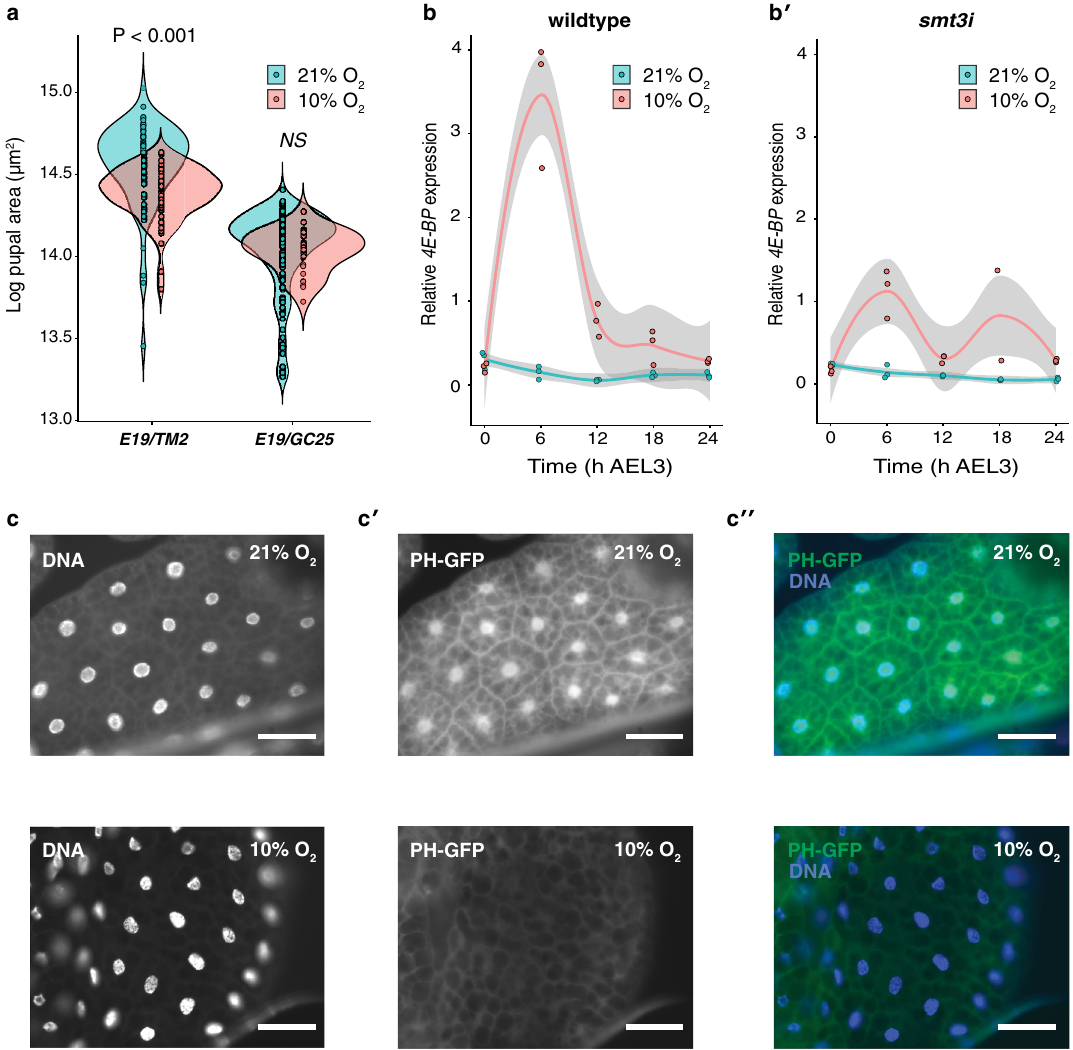
Figure 2. Moderate hypoxia reduces body size by suppressing IIS activity. ( a ) Suppression of the Insulin- Signaling pathway is necessary to inhibit growth under hypoxia. Adult body size shown in log pupal case area in flies functional IIS (E19/TM2) and flies with suppressed IIS (E19/GC25). Mean pupal size for each genotype across oxygen levels was compared using a pooled t-test. NS: not significant at P > 0.05. ( b ) Hypoxia increases expression of 4E-BP in the first 24 h after ecdysis to the third larval instar (AEL3) relative to normoxic controls. ( b’ ) This increase in expression is alleviated in smt3i larvae, which have reduced ecdysone levels. ( c,c’,c’’ ) TGPH membrane localization in the fat body cells under hypoxic and normoxic conditions. TGPH localizes to the cell membrane when IIS-pathway activity is high. White bars represent 100 µm. Grey bands are 95% confidence limits around the